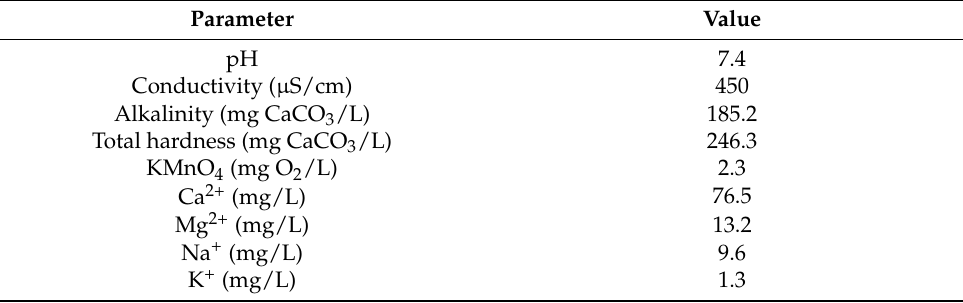
Table 2. Characterization of tap